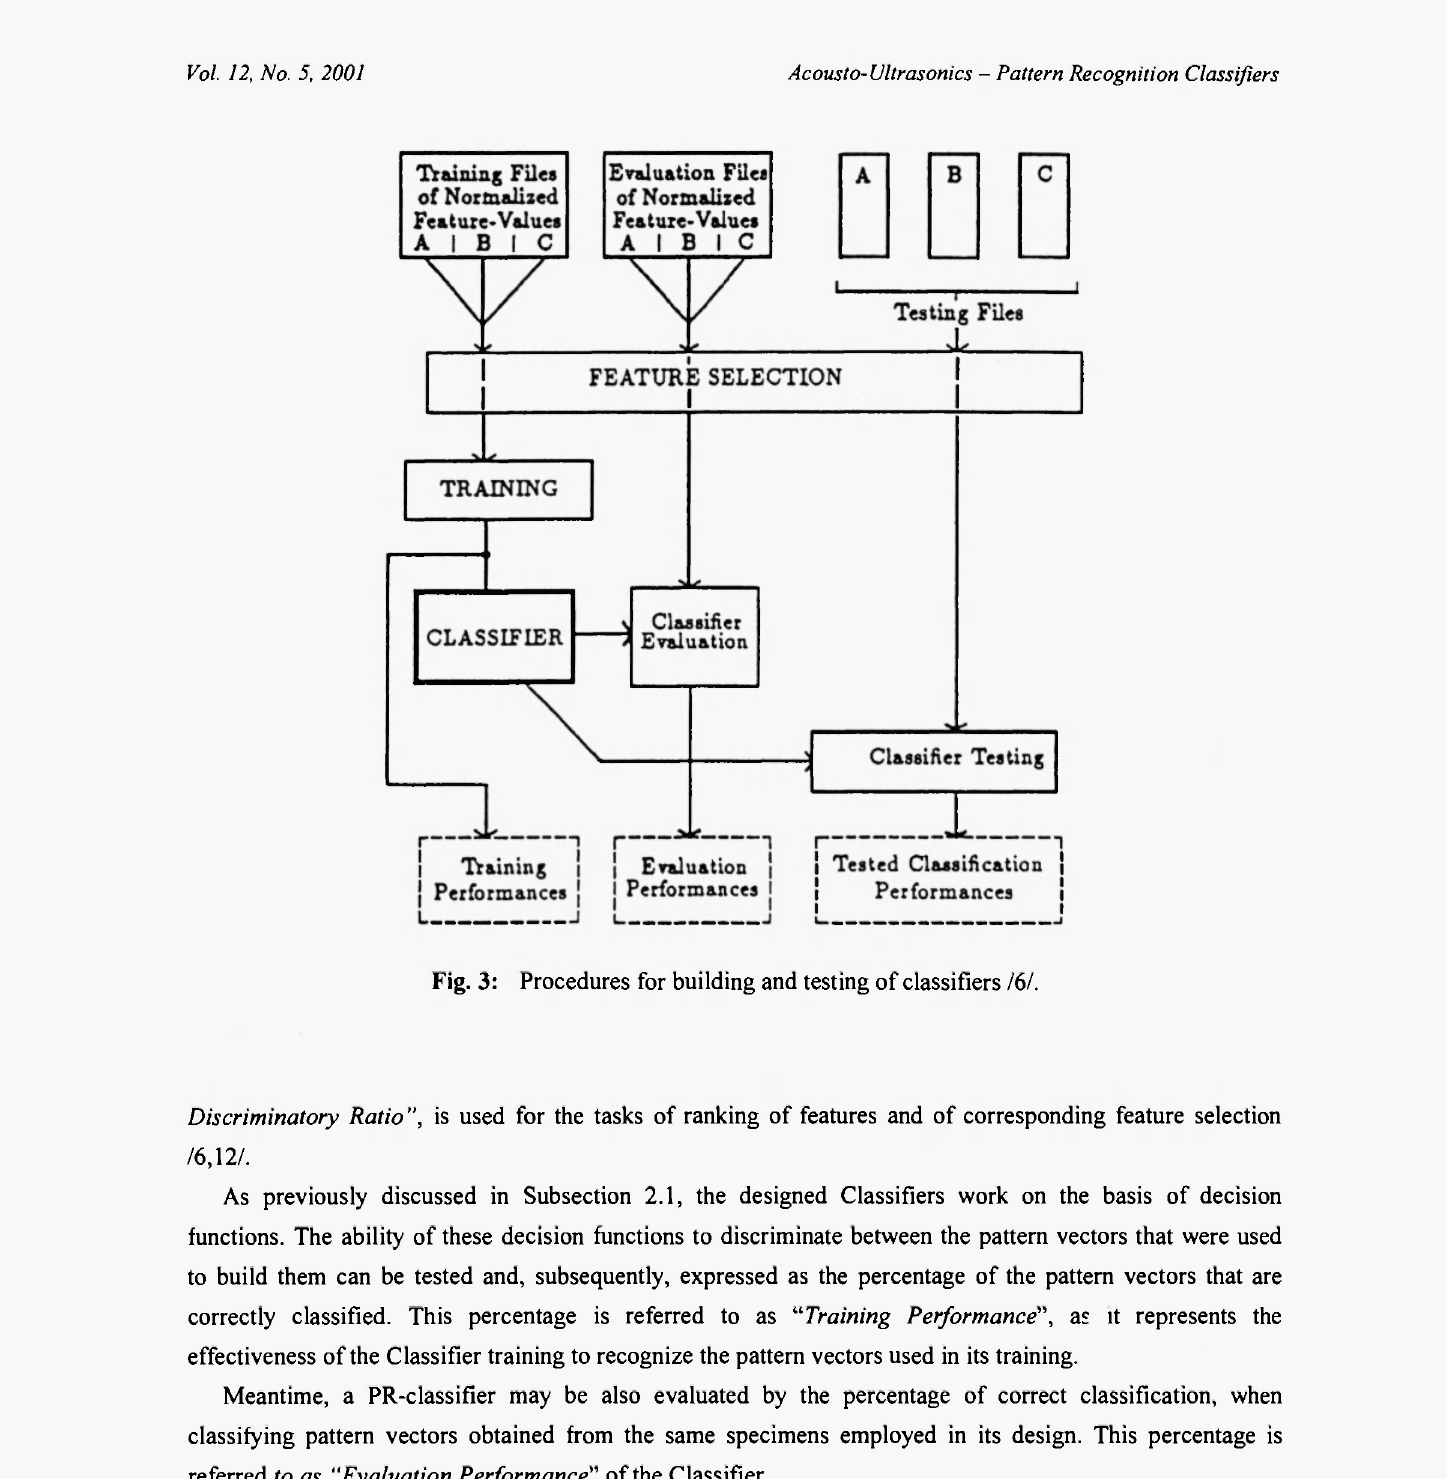
Fig. 3: Procedures for building and testing of classifiers